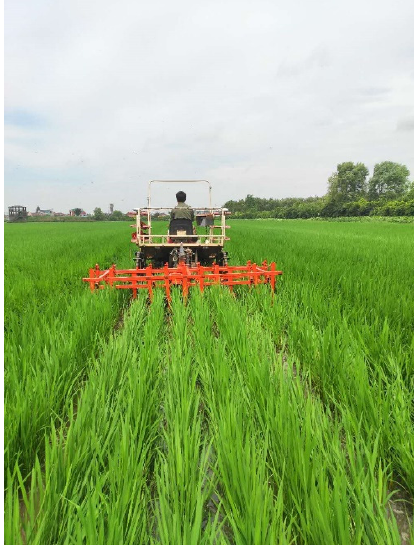
Figure 9. Weeding effect of reciprocating inter-row paddy weeding machine for strip-seeded rice.